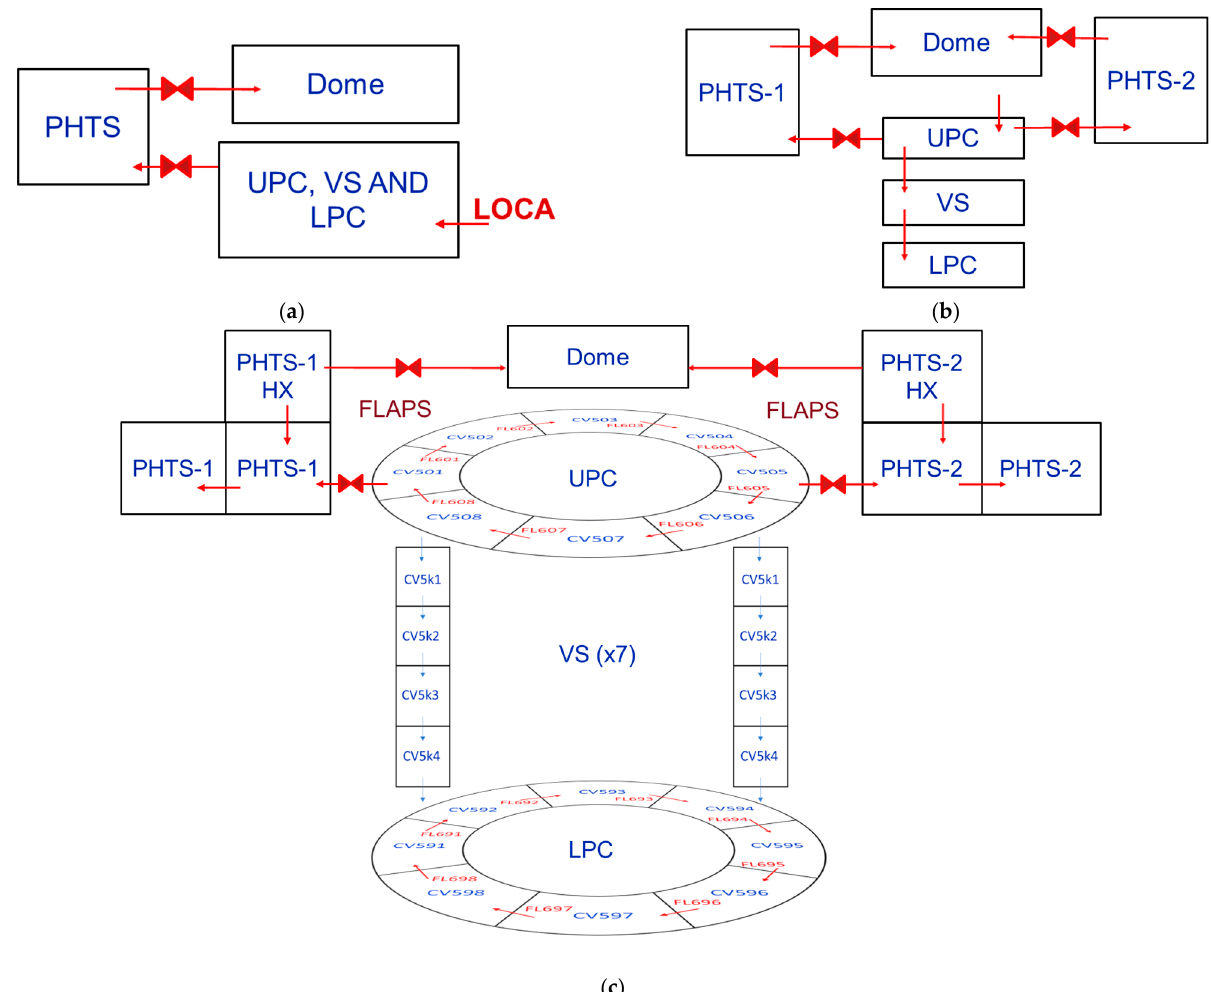
Figure 5. Different MELCOR nodalization schemes for UPC, VS, LPC, PHTS area, and dome: ( a ) Case 1: Single Volume Approach; ( b ) Case 2: Simplified Model; ( c ) Detailed model.